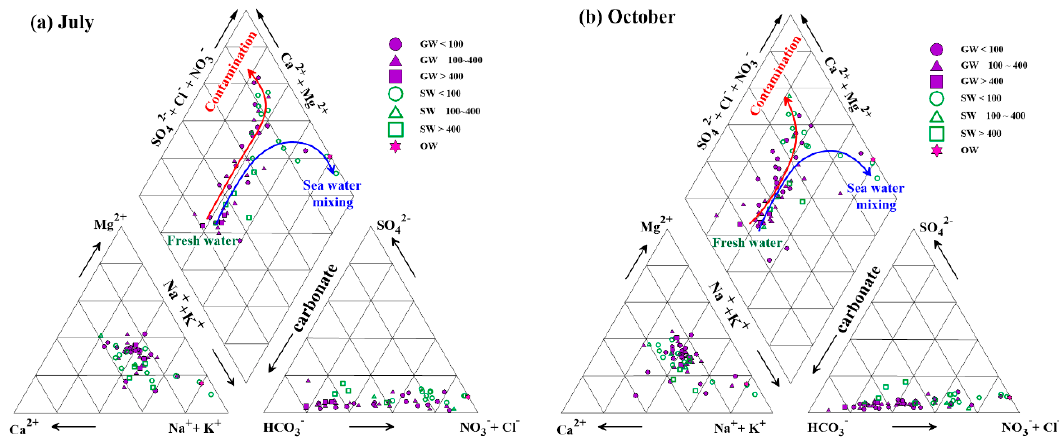
Figure 5. Piper diagram of the major chemical compositions of groundwater (GW, solid symbols), spring water (SW, open symbols) and sea water (OW) expressed in milli-equivalent percentages. ( a ) and ( b ) represent July and October as sampling seasons, respectively.